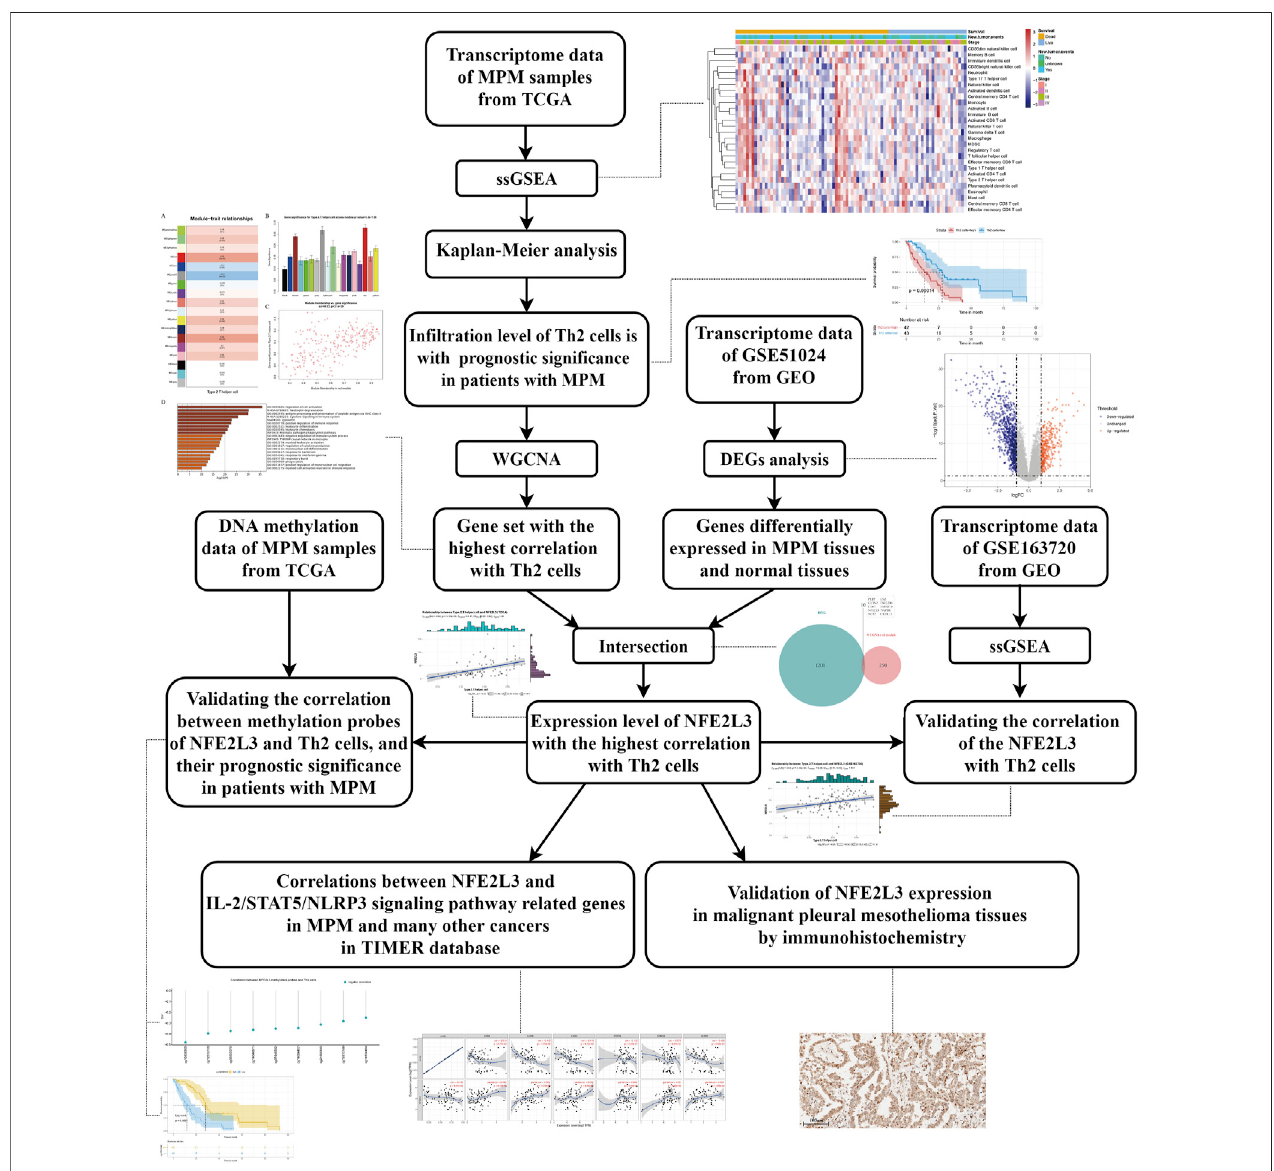
FIGURE 1 | The detailed work fl ow of this study. MPM, malignant pleural mesothelioma; TCGA, The Cancer Genome Atlas; ssGSEA, single-sample gene set enrichment analysis; Th2 cells, type 2 T helper cells; WGCNA, weighted gene co-expression network analysis; GEO, Gene Expression Omnibus; DEGs, differentially expressed